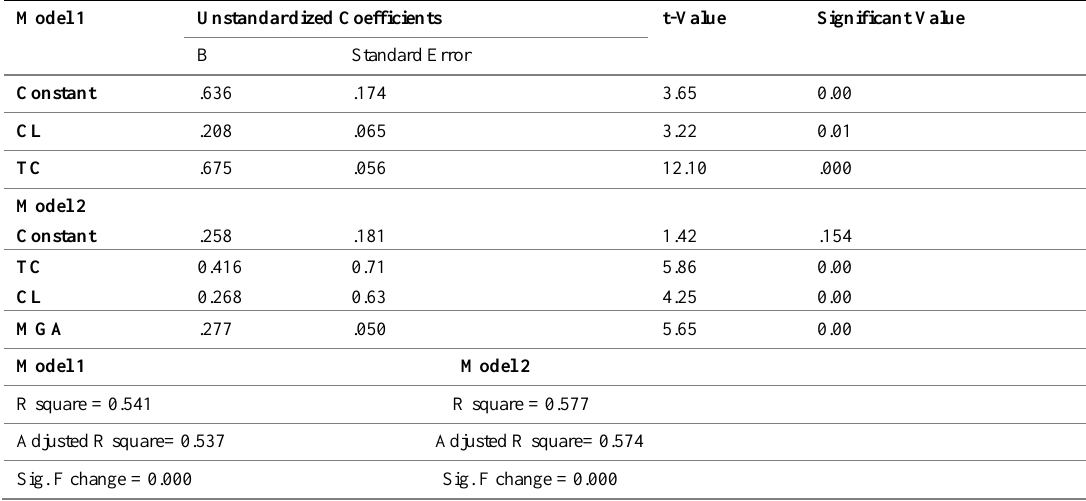
Table 3: Hierarchical regression